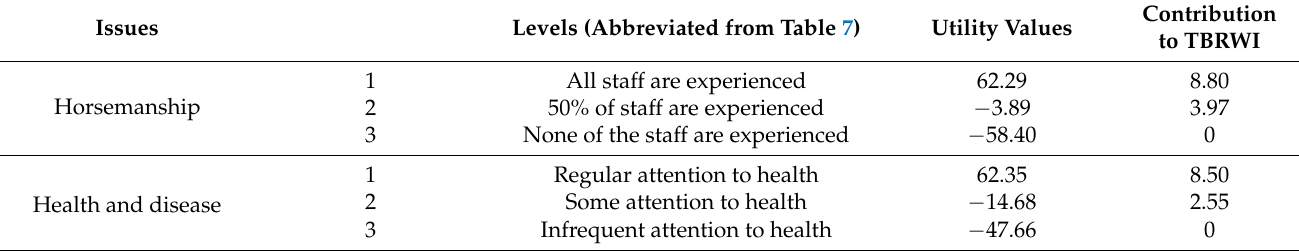
Table 8. Composition of TBRWI from utility values obtained from issues, levels and their level of importance values from the Thoroughbred racehorse husbandry questionnaire and the trainer survey. Issues